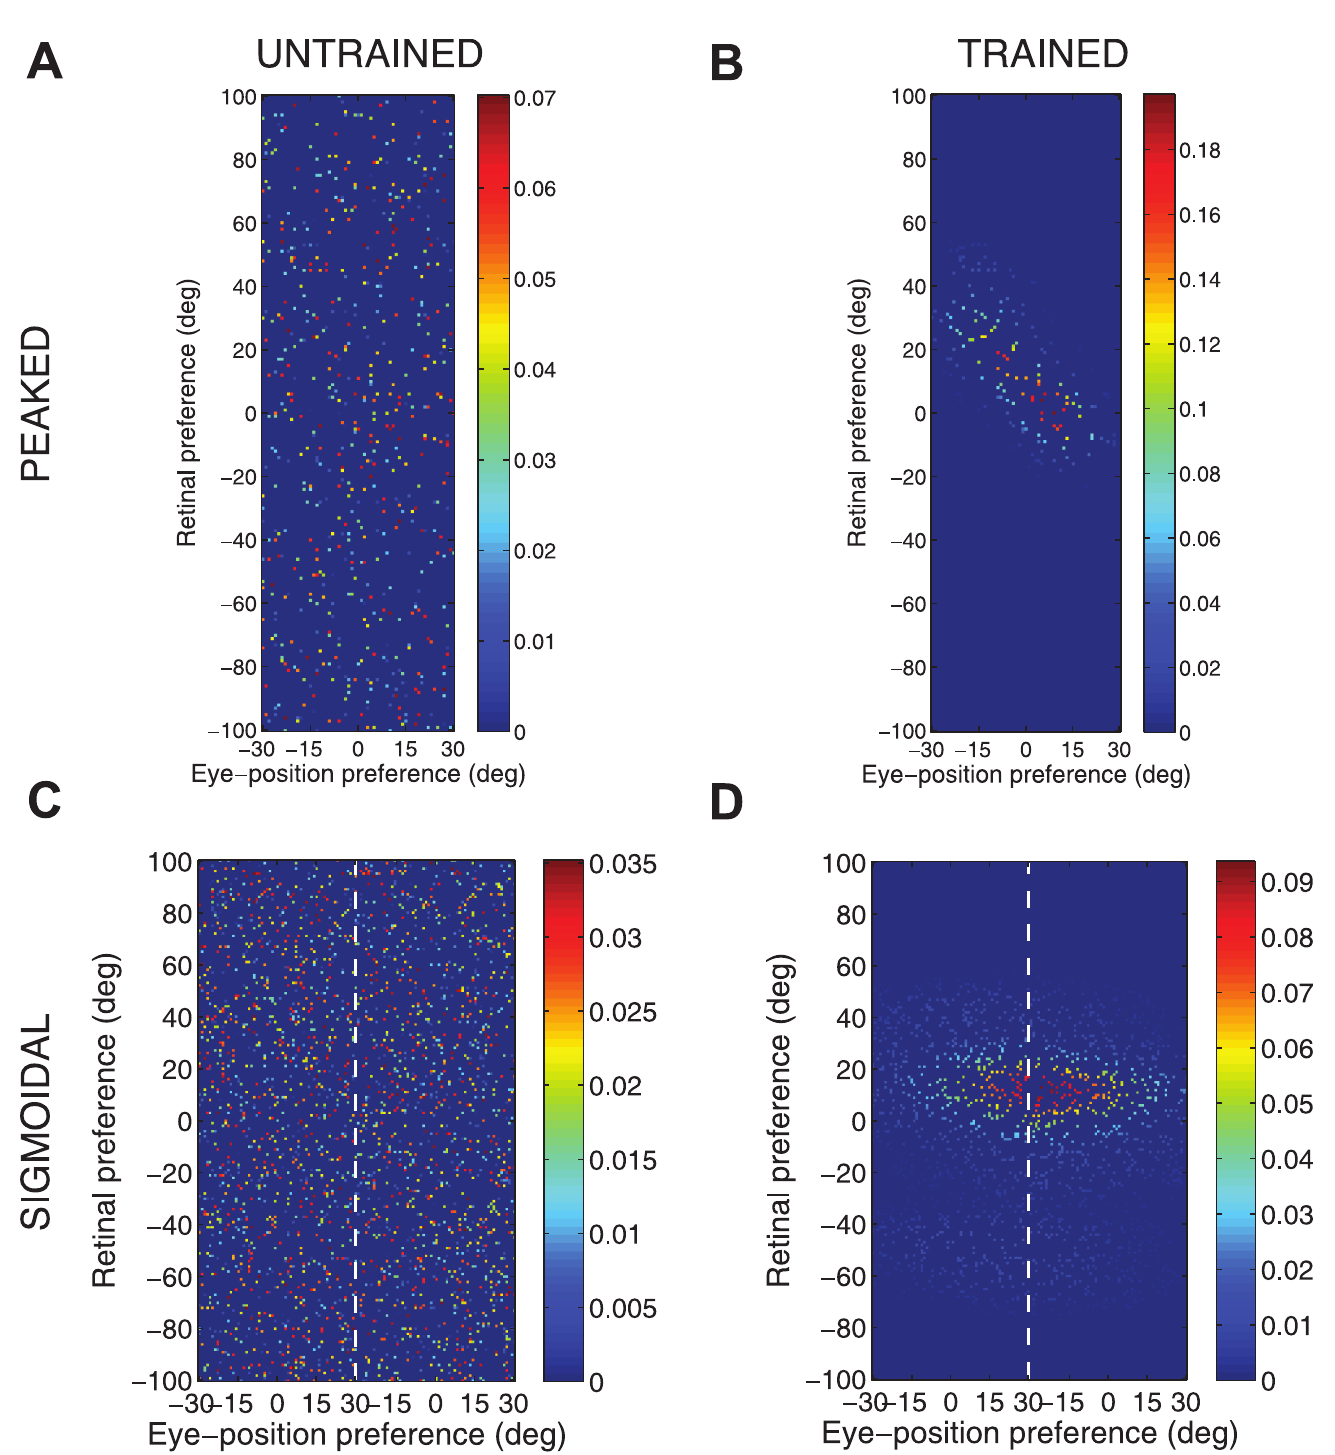
Fig 4. Strengths of the afferent synapses from the input population to a typical output neuron during testing. Results are shown for the model with peaked eye-position gain modulation before training (A) and after training (B) , and for the model with sigmoidal eye-position modulation before training (C) and after training (D) . The output neurons correspond to those plotted in Fig 3. In each plot, the afferent synapses have been arranged topographically by the preference of the input neuron for retinal location α and eye-position β . For the model with sigmoidal gain modulation, there are two input neurons for every combination of i j retinal preference and eye-position preference, but with opposite eye-position gain. Consequently, the input population has been separated by gain direction. The portion of each plot to the left of the white dashed line corresponds to input neurons with positive gain κ > 0, while the portion of each plot to the right of the j